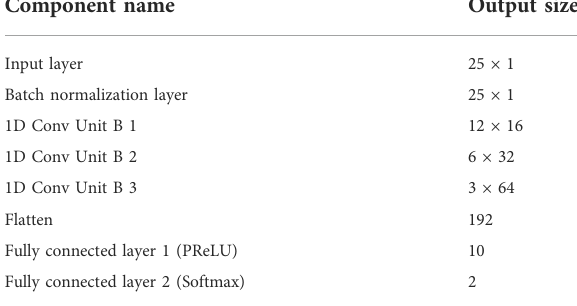
TABLE 3 Parameters details of the 1D-CNN network.